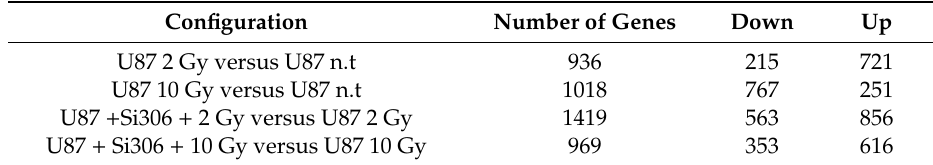
Table 5. Number of genes significantly deregulated by 2-fold or greater in all the configuration modalities assayed in this